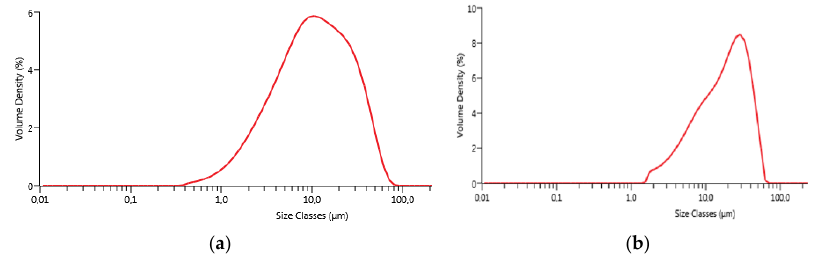
Figure 2. Laser granulometry measurement results: ( a ) OSR700; ( b ) SWP 700.